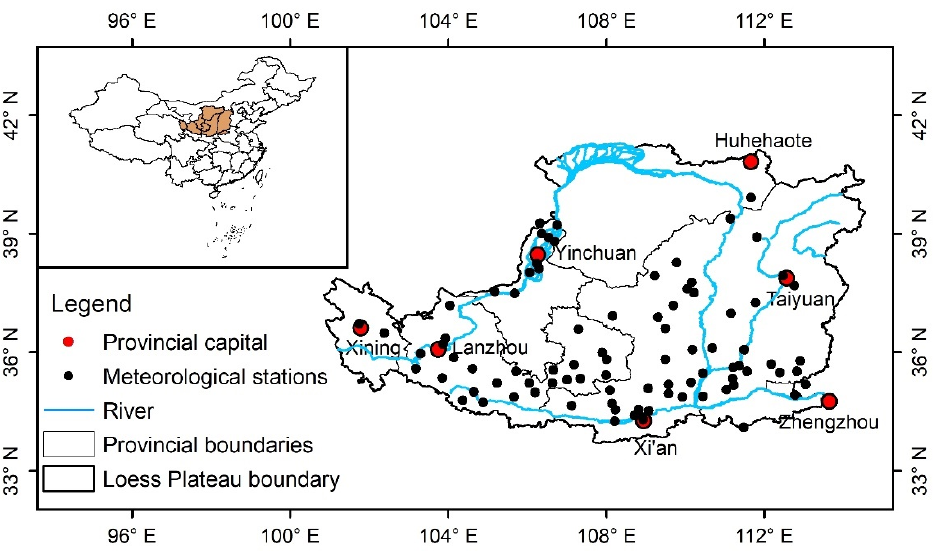
Figure 1. Location of the Loess Plateau (LP) and the distribution of 87 meteorological stations on the LP.